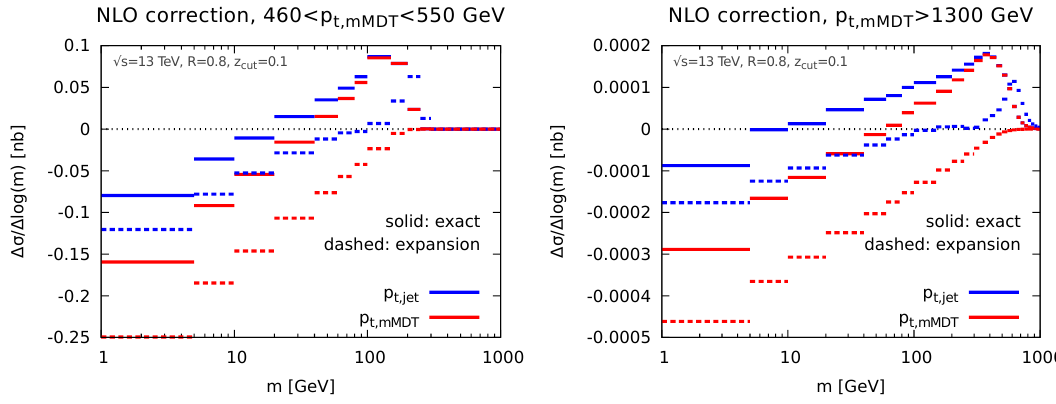
Figure 7 . Comparison between the full NLO correction (solid) to the jet mass distribution and the O ( (cid:11) 2 ) expansion of the LL resummation (dashed) for both p t; jet (blue) and p t; mMDT (red) in s two di(cid:11)erent transverse momentum